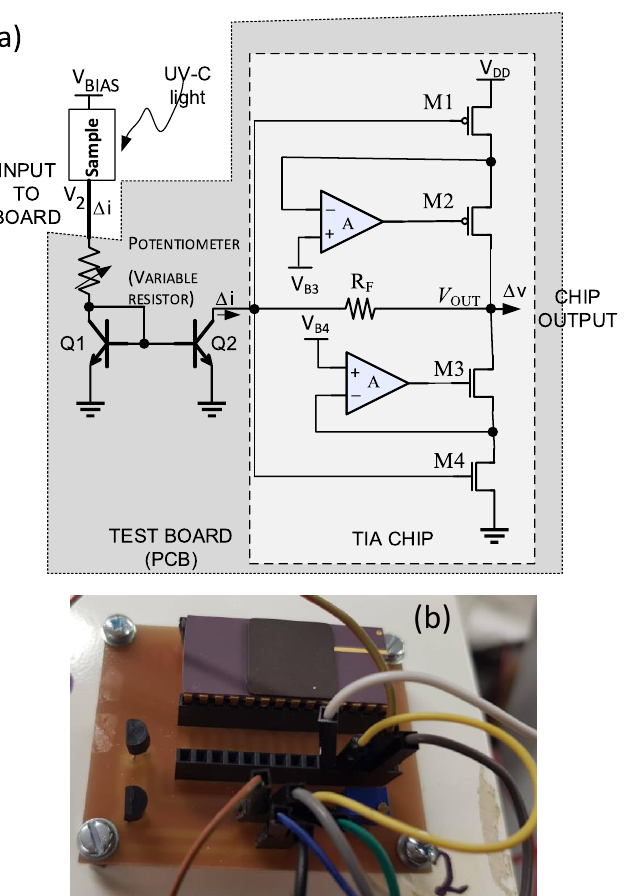
Figure 2. ( a ) Schematic diagram of the TIA chip and test board setup and ( b ) photograph of the fabricated test board with TIA chip.